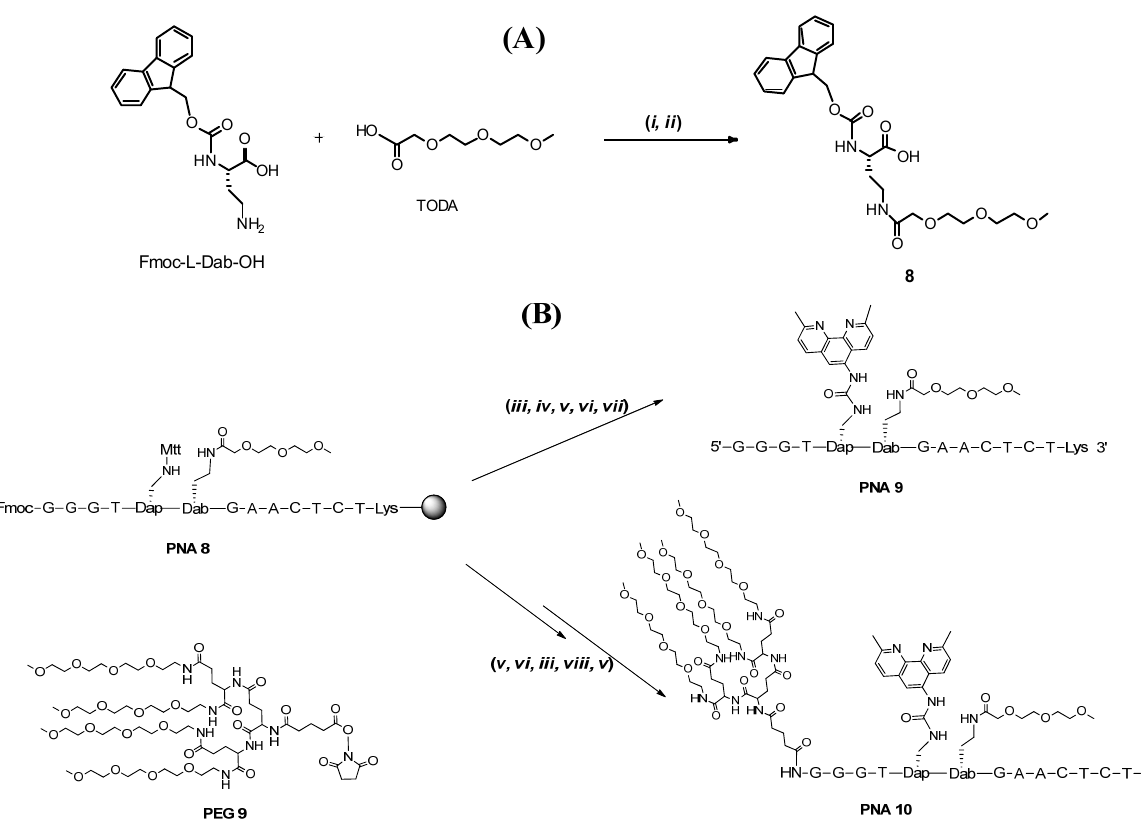
Scheme 3. Synthesis of amino acid 8 ( A ), neocuproine and oligoether conjugate PNA 9 and PNA 10 ( B